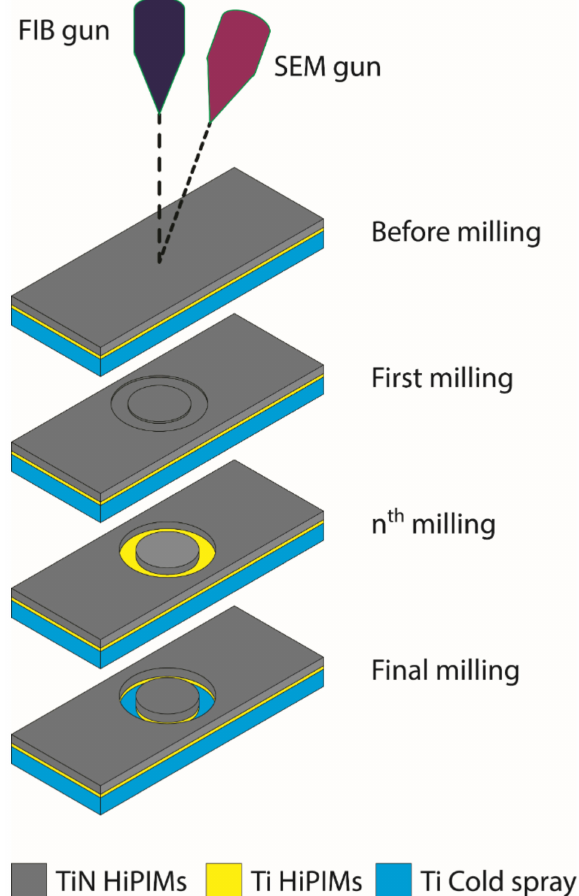
Figure 5. Schematic diagram of the the ring-core milling